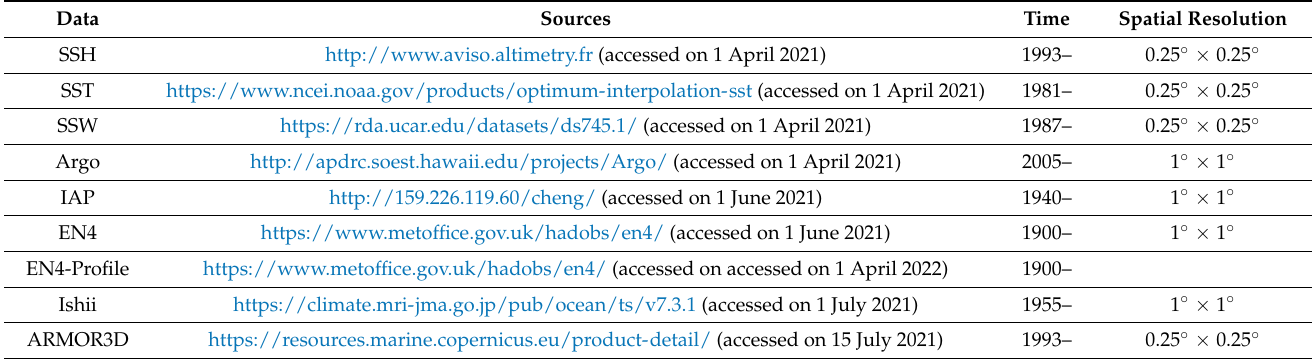
Table 1. Data used in this